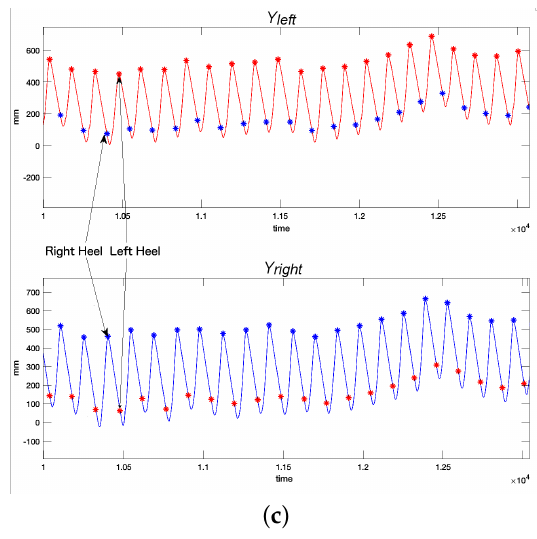
Figure 2. Optotrak gait analysis from a healthy volunteer. ( a ) Optotrak’s markers in the heels; ( b ) Optotrak’s Z and Y values of the left heel in user 6 and ( c ) top peaks in left ( Y left ) and right ( Y right ) functions.